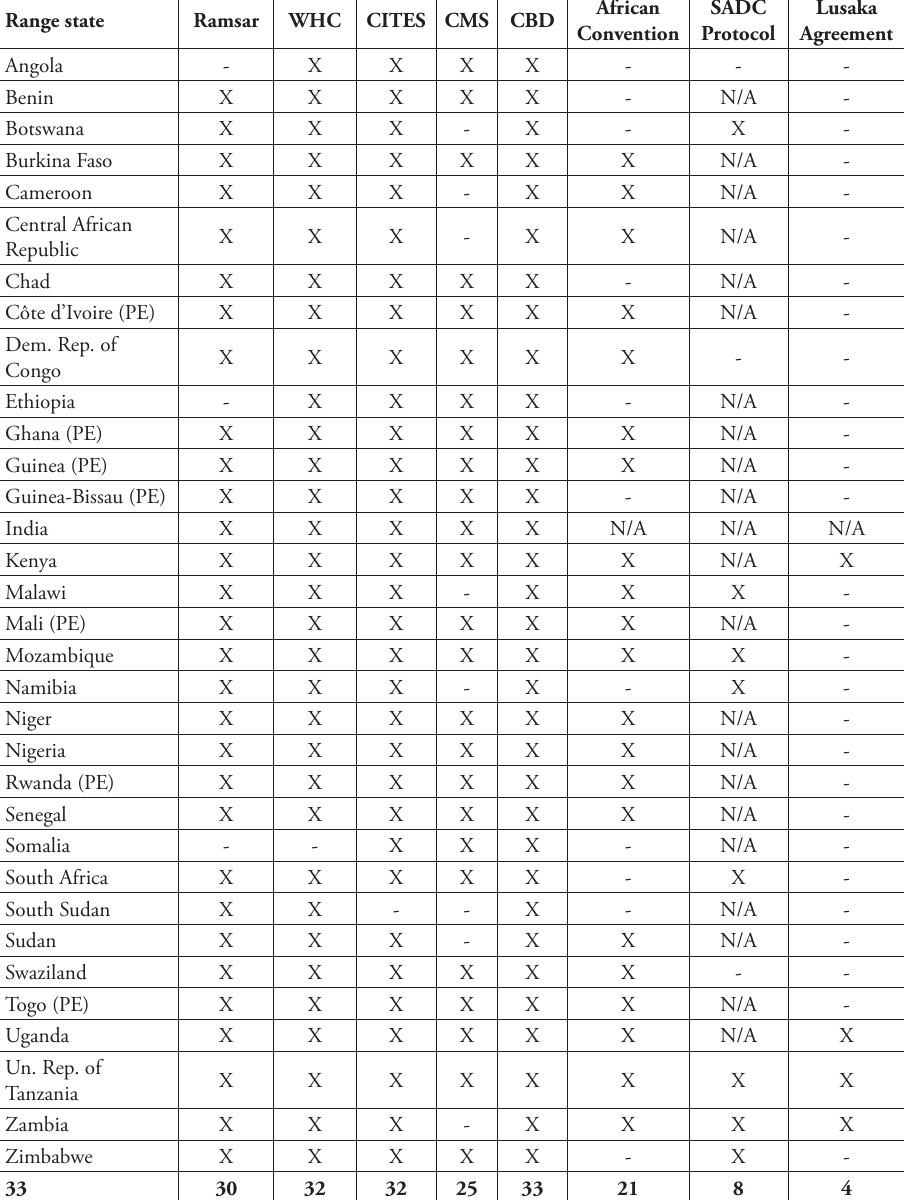
Table 2. Lion range states and their participation in relevant treaties. List of lion range states as provided in the IUCN Red List of Threatened Species 2016 (excluding previous range states in which the species is known to be extinct), indicating their participation in relevant treaties. PE = possibly extinct; X = con- tracting party; - = not currently a contracting party, but could become one; N/A = not applicable (i.e. the country falls outside of the instrument’s geographic